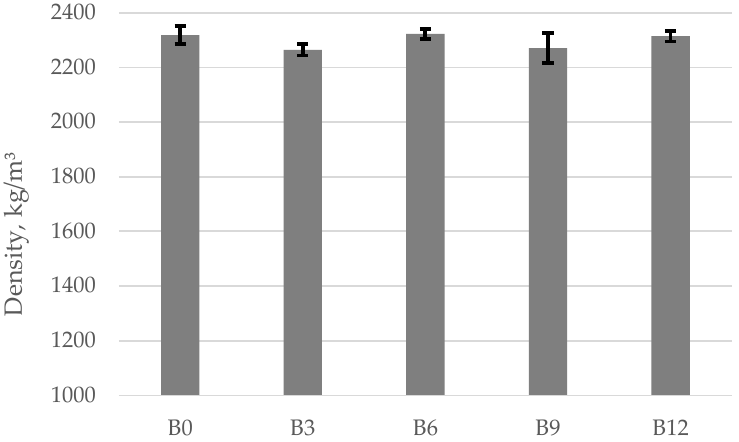
Figure 2. Average density values for concrete specimens containing ash.